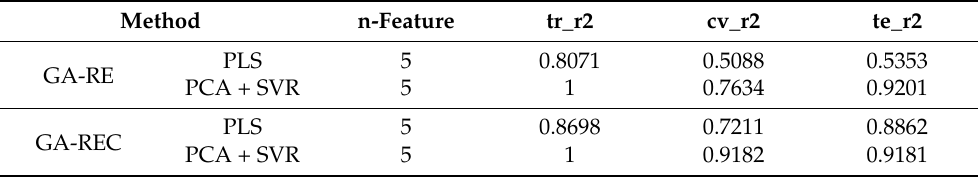
Table 4. R 2 of different models on training set, cross-validation, and test set.